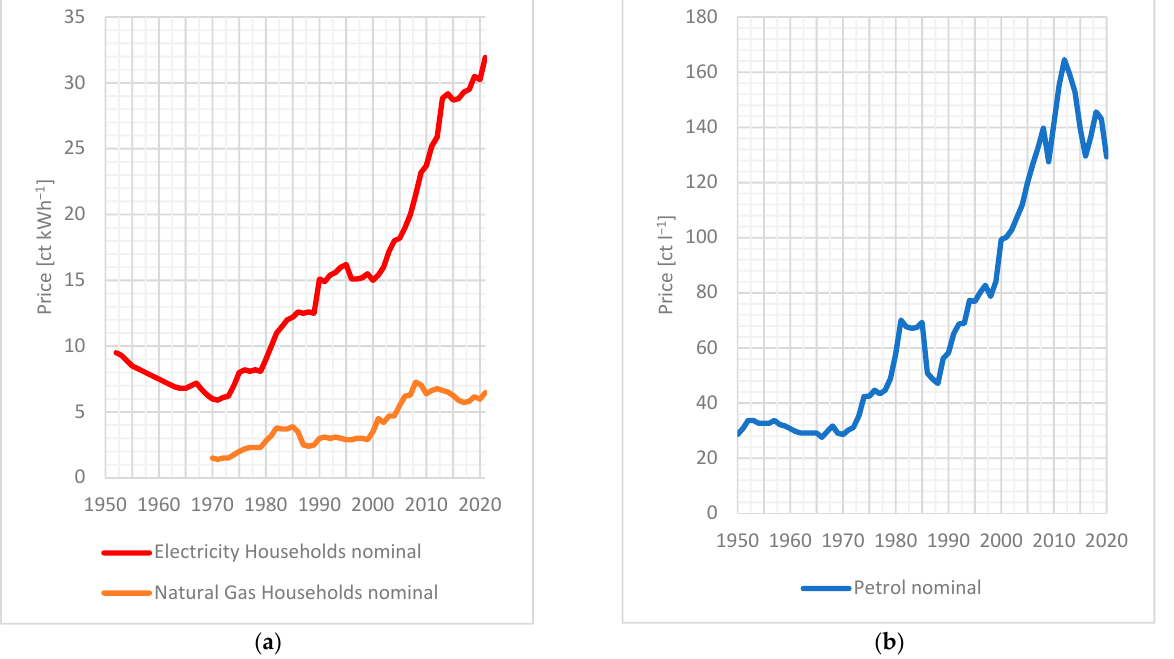
Figure 3. Development of nominal end customer prices: ( a ) Nominal price developments of electricity and natural gas for private households in Germany from 1950 until the second quarter of 2021 (natural gas from 1970 due to lack of data for previous decades). Data based on [47 – 50]. ( b ) Nominal price developments of petrol for private customers in Germany from 1950 to 2020. Data based on [47].